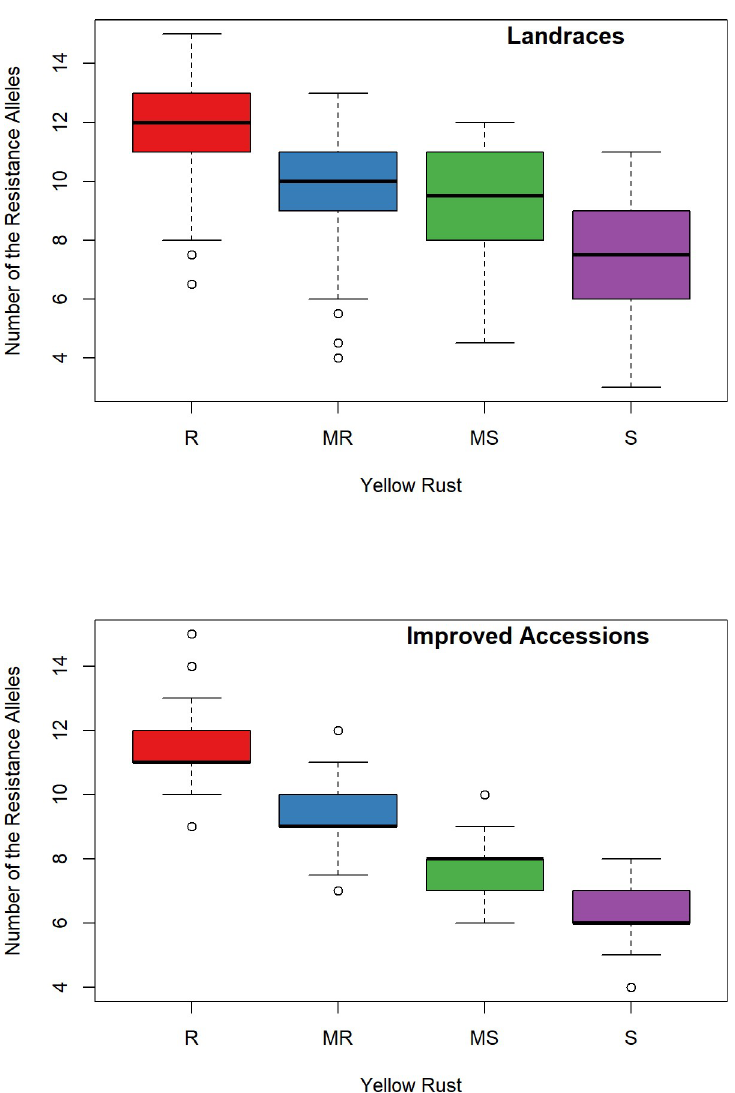
Fig 7. Boxplot for the number of favorable alleles effect on stripe rust resistance for the improved accessions and the landraces.